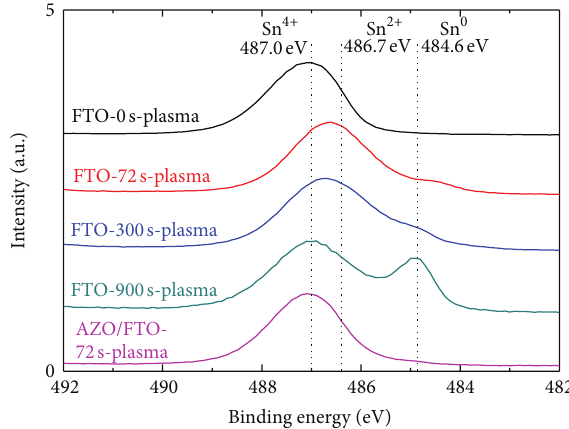
Figure3:Sn3d 5/2 signalofXPSspectrumasafunctionofH 2 plasma exposure time for FTO and AZO/FTO films.